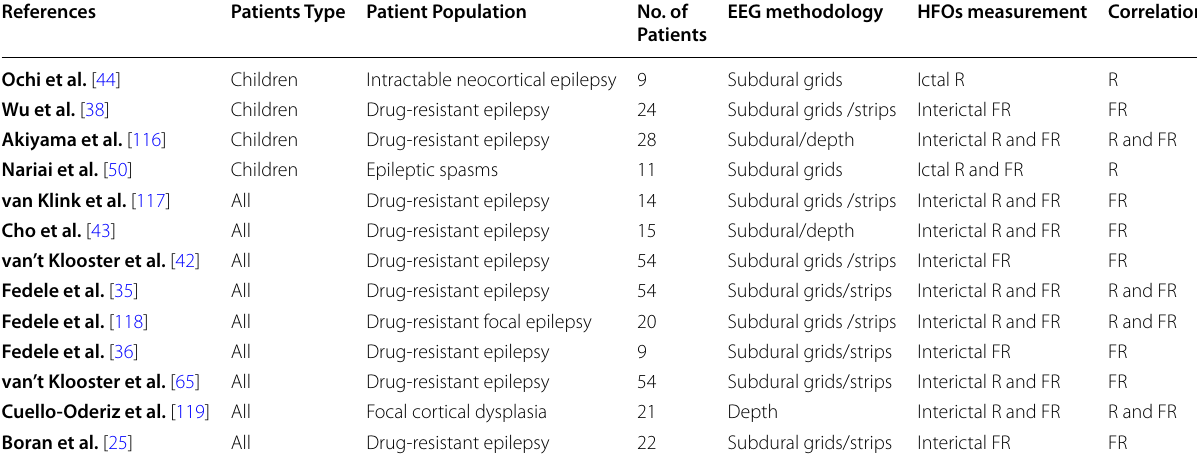
HFOs High-frequency oscillations, EEG Electroencephalogram, R Ripples, FR Fast